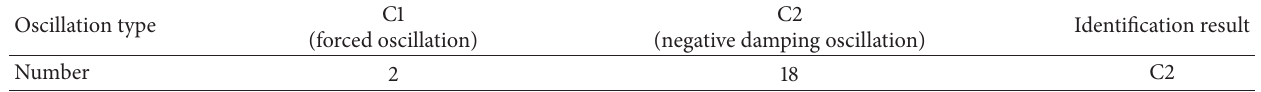
Table 3: Identification result of oscilloscope records of negative damping oscillation